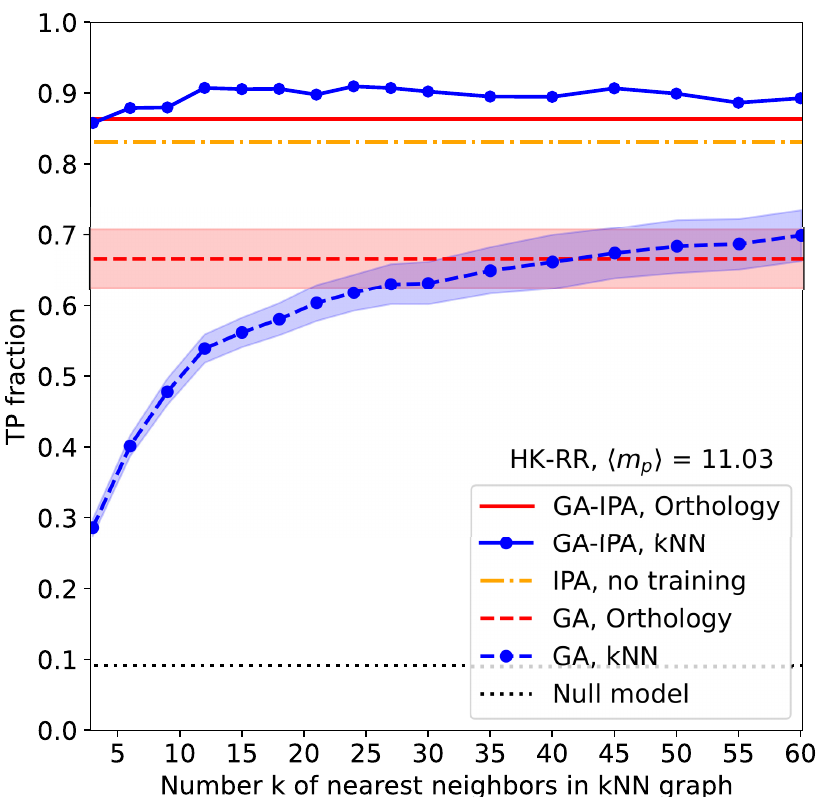
Fig 4. GA-IPA outperforms both GA and IPA. The mean fraction of true-positive pairings (TP ratio) is shown as a function of the number of nearest neighbors k in the kNN graph. We combine GA and IPA in our GA-IPA method: we use the robust pairs obtained by GA as a seed co-MSA for IPA. The results of GA and of IPA without seed co-MSA from Fig 2 are shown for comparison. For IPA, we use N increment = 6, both without (IPA) and with (GA-IPA) seed co-